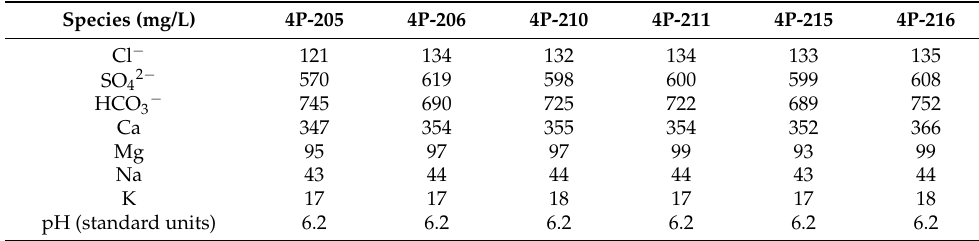
Table A2. Major ion chemistry in production wells used in the amendments test in September 2017, prior to the start of the tracer test (U not measured, but see Figure A1 for U trends over time in 4P-216).